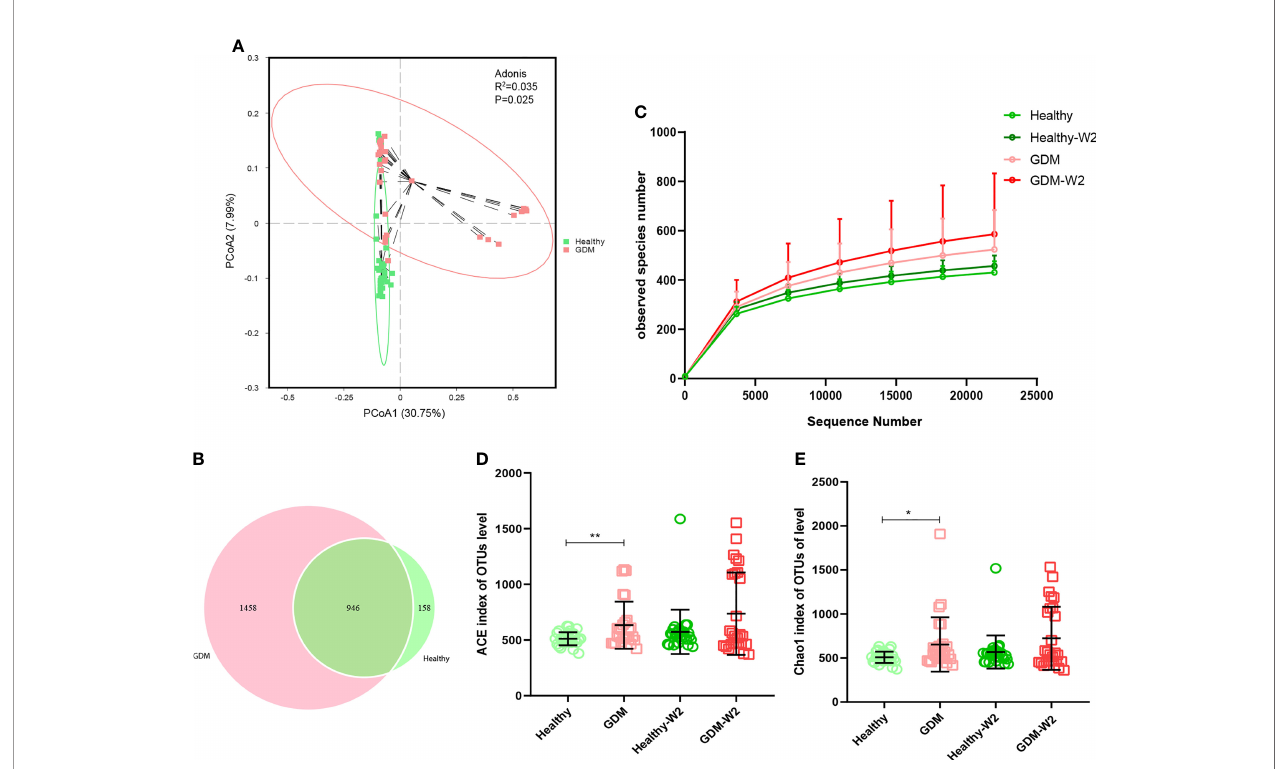
FIGURE 2 | Comparison of the fecal microbiota composition between the GDM and healthy groups. (A) Principal coordinate analysis (PCoA) at the OTU level between the GDM and healthy groups at enrollment. (B) Venn diagram illustrating the overlap of the OTUs identi fi ed in the fecal microbiota between the GDM and healthy groups at enrollment. (C) Observed species of 4 groups, including the GDM and healthy and the GDM-W2 and healthy-W2 groups. D & (E) Alpha-diversity based on the ACE index and Chao 1 index at the OTU level. Mann-Whitney test, GDM vs. healthy, ** P <0.01, * P